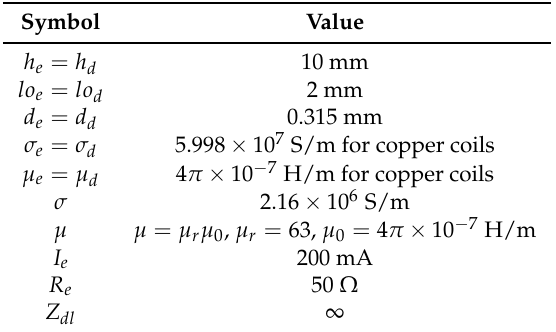
Table 3. Fixed parameters (constants) used for simulation.